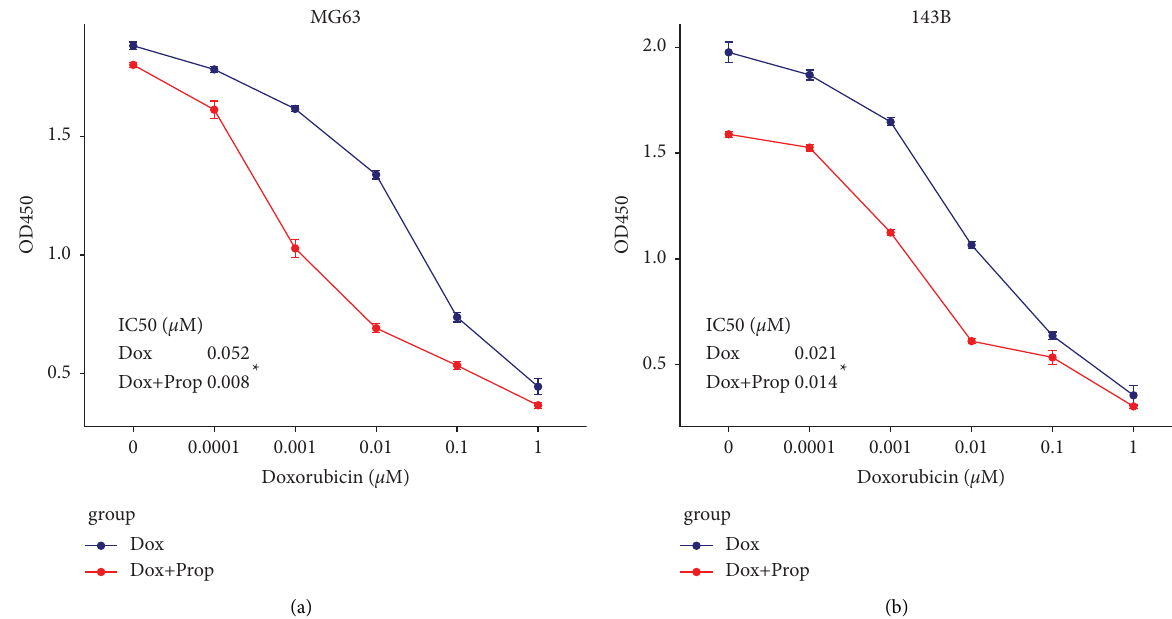
Figure 3: Propofol sensitized osteosarcoma to doxorubicin-induced growth inhibition. Doxorubicin single agent (increasing concen- trations) or in combination with propofol (2.5 μ M) was used to treat the MG63 and 143B cells. Te dose-response curves were plotted based on the remaining viable cell numbers and the IC50s were calculated in both conditions in the two cell lines. Te IC50s were signifcantly lower in the combined therapy group than those in the doxorubicin single agent treatment group. Each experiment was conducted with 5 biological repeats. ∗ p < 0 .